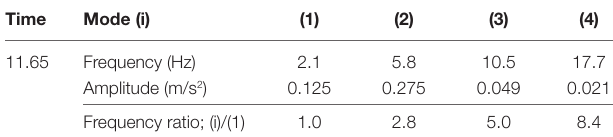
Table 6 | Dominant frequency in amplitude